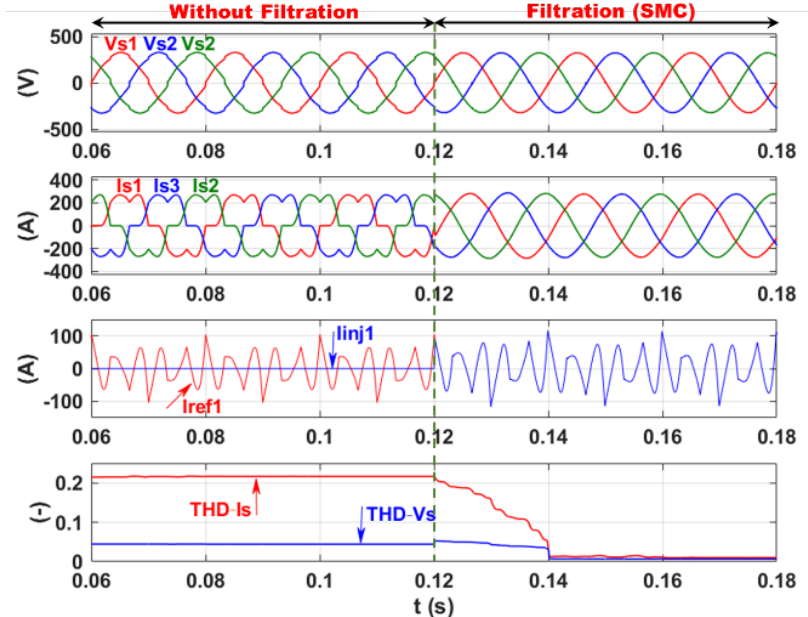
Figure 7. Current and voltage filtering using time domain SMC .